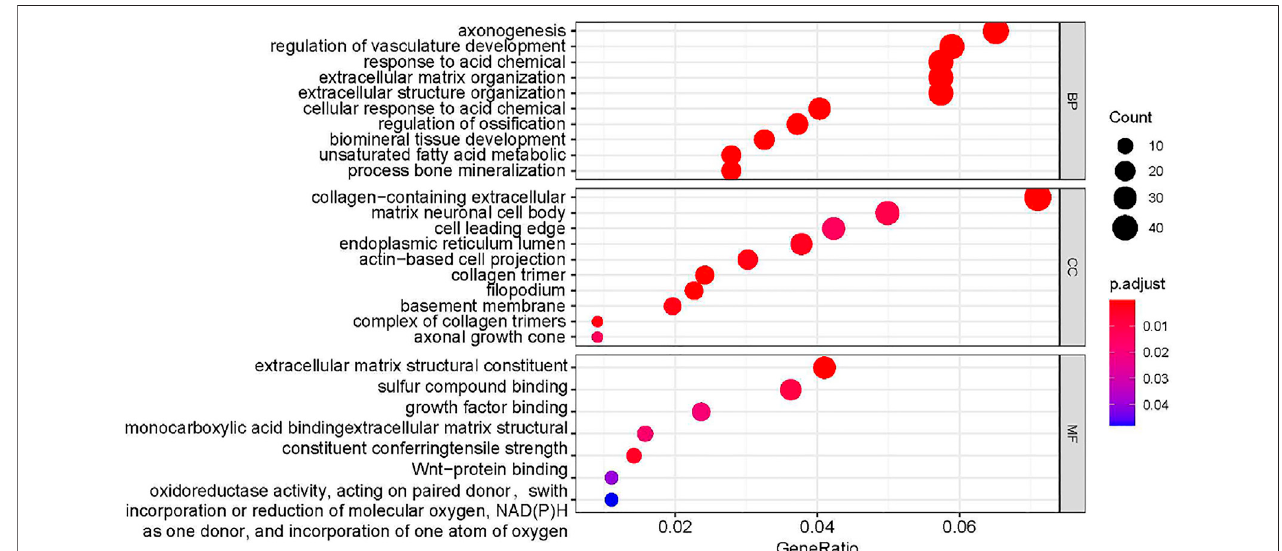
FIGURE 3 | Analysis results of functional enrichment.